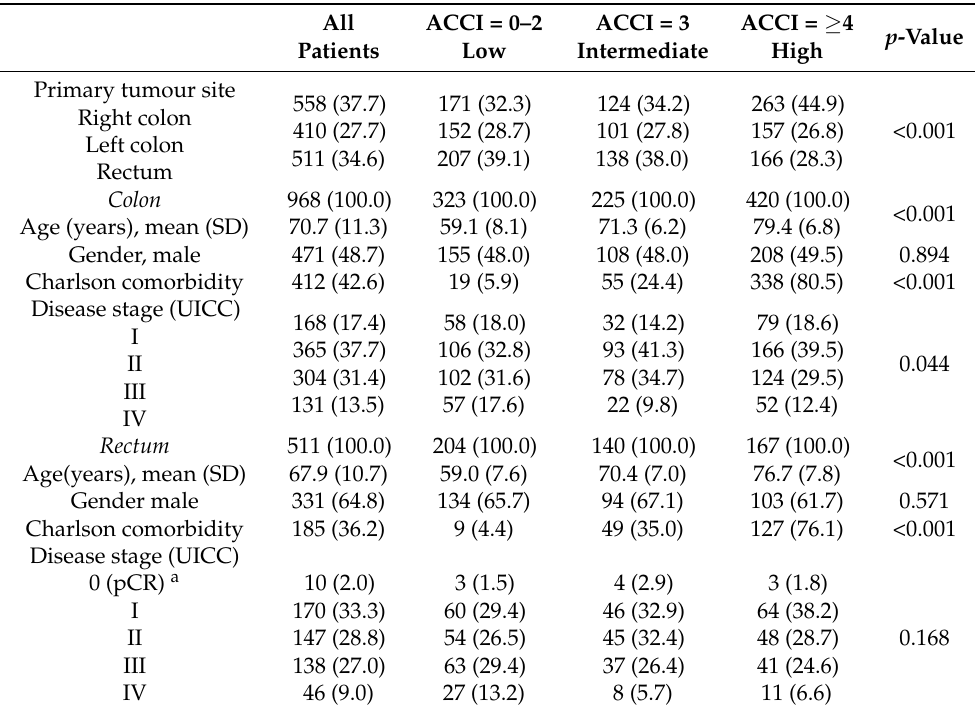
Table 2. Patient characteristics and tumor stage distribution by low, intermediate and high age- adjusted Charlson comorbidity index